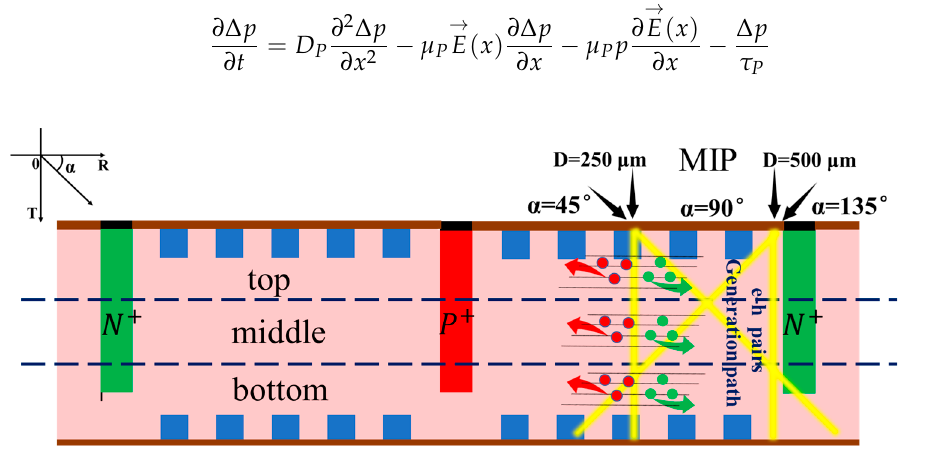
Figure 9. Schematic diagram of the incidence of MIP at different positions.